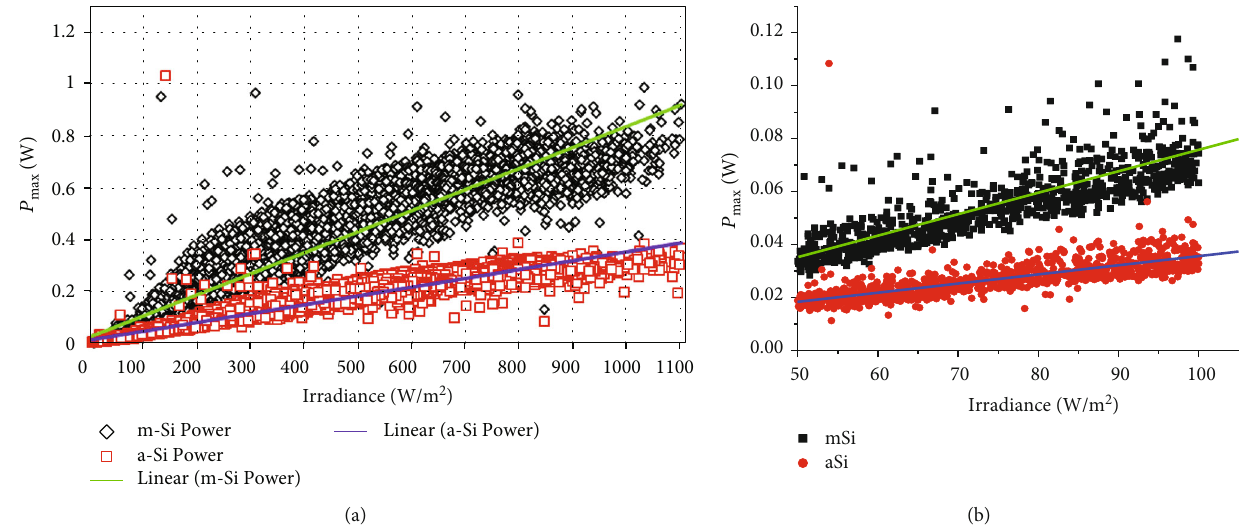
Figure 3: The maximum power of the two PV panels. (a) Irradiance from 0 to 1100 W/m 2 . (b) Irradiance from 50 to 100 W/m 2